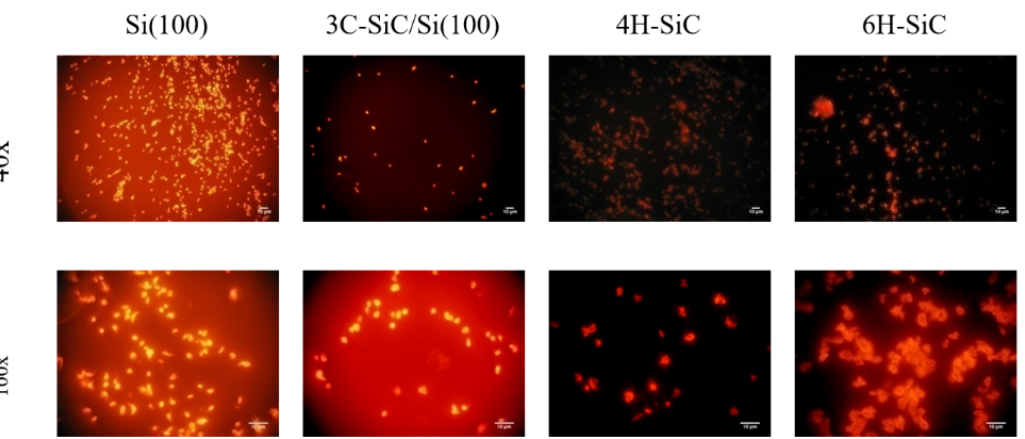
Figure 2. Static hemocompatibility study. Fluorescent micrographs comparing adhered platelets on three different SiC polytypes and Si. 3C-SiC clearly shows lower adhesion and high circularity while Si presented the highest adhesion. 4H and 6H-SiC evidenced the presence of clumps and a high degree of activation [2].